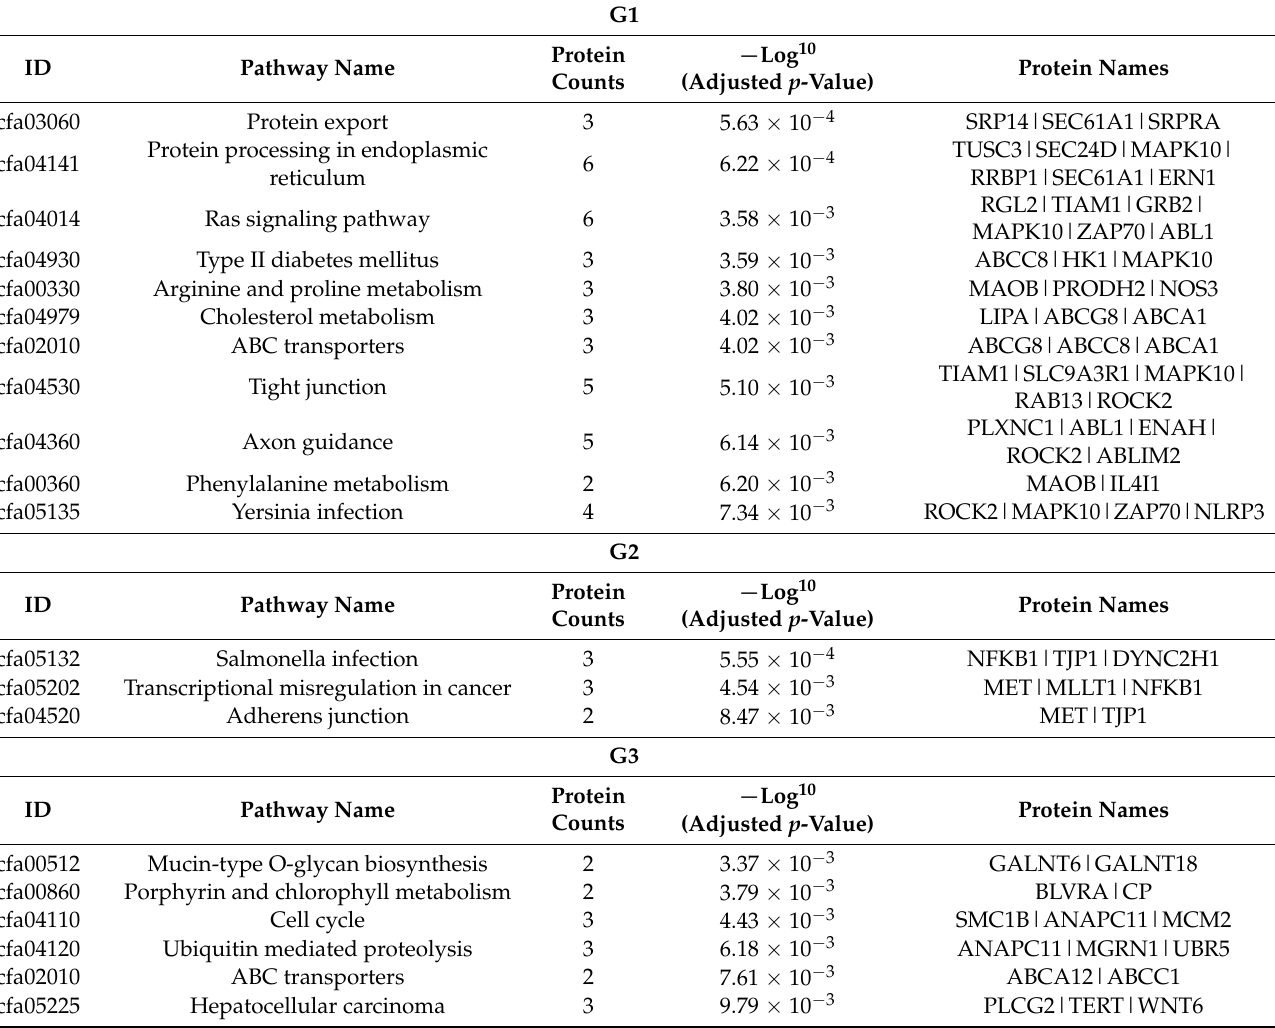
Table 3. The KEGG (Kyoto Encyclopedia of Genes and Genomes) pathway analysis of the epididymal spermatozoa of dogs ( Canis lupus familiaris ) in different age groups (G1: 12–41 months old; G2: 42–77 months old; G3: 78–132 months old). p ≤ 0.01. Gene name abbreviations were explained in Tables S1–S3.